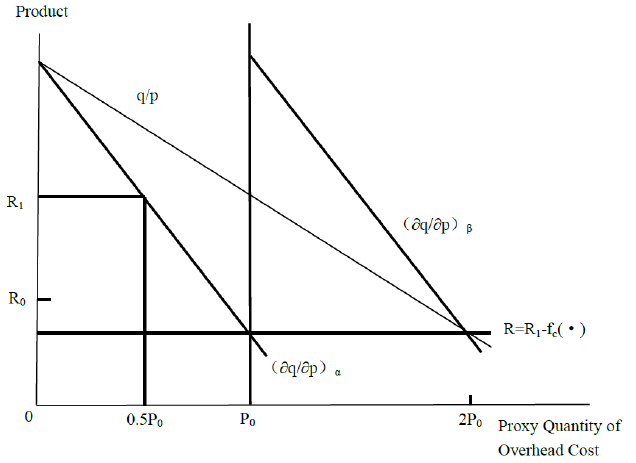
Figure 2. Transaction costs and the Illustration of Overpricing Mechanism to Increase Rent.